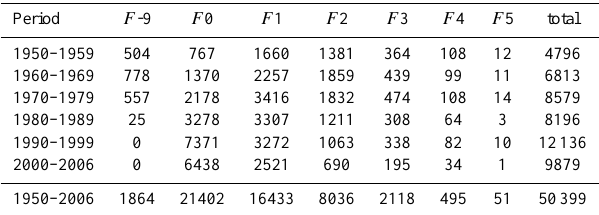
Table 1. Tornado numbers in Fujita intensity classes from F 0 to F 5 with F -9 indicating unrated tornadoes, source: SPC, period: 1950–